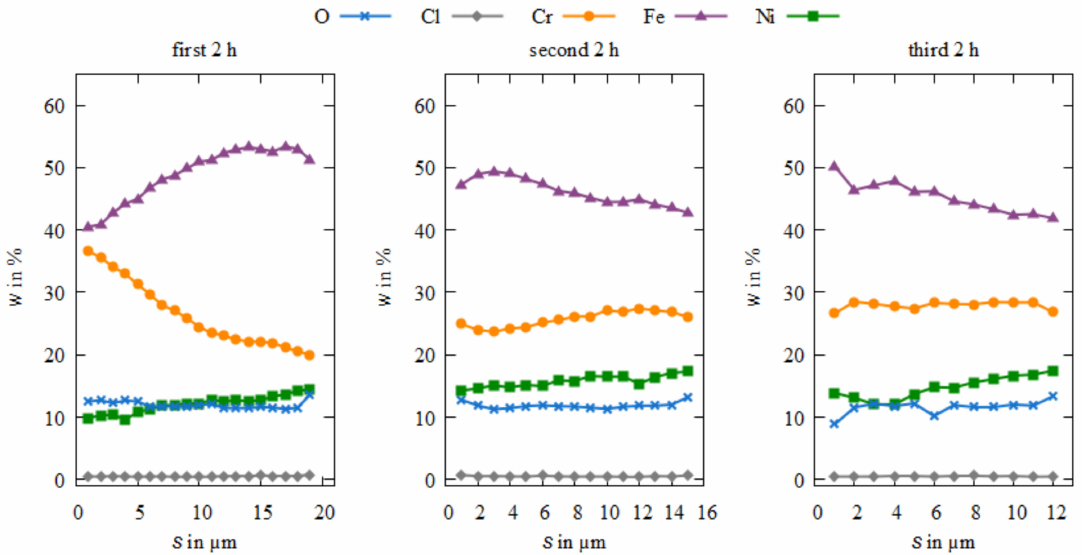
Figure 14. EDXS measurement of alloy compositions over the entire layer thickness of the stepped DC t on = 10 s, t off = 5 s samples depending on the electrolyte